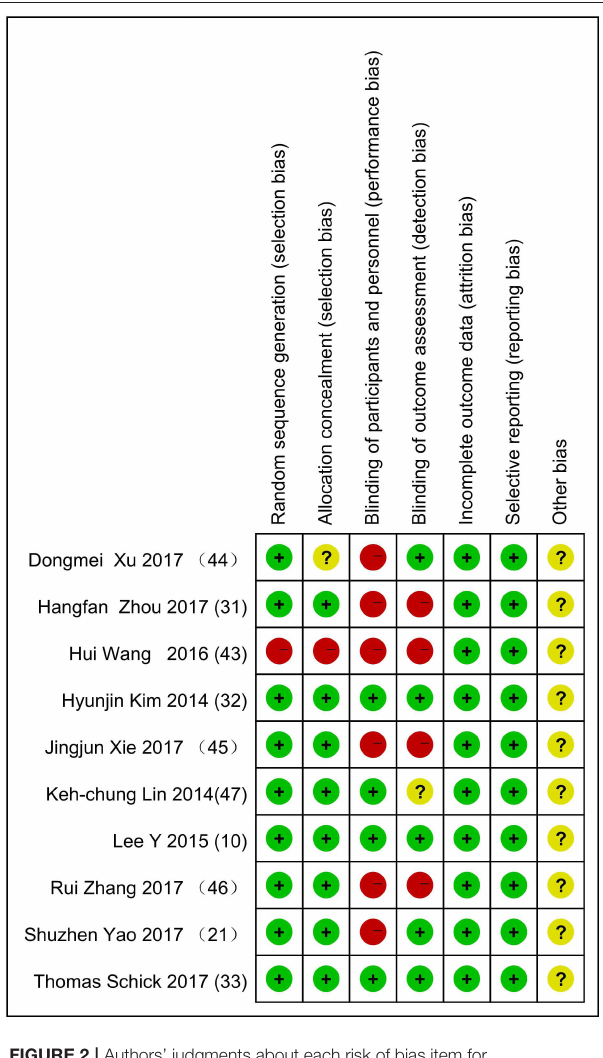
FIGURE 2 | Authors’ judgments about each risk of bias item for included